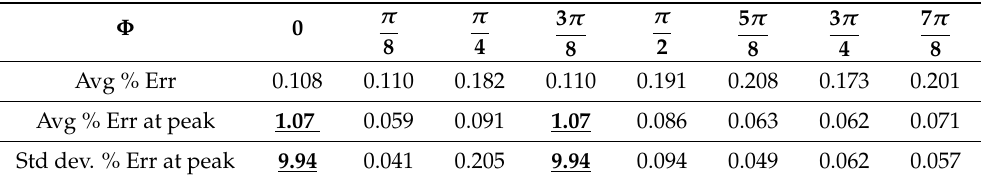
Figure 10. Legend for Figure 9. Table 7. Percent Error for CS reconstruction for each Φ for R = 42,000 km. The second row shows average % error over all time samples, the third row shows average % error at t 0 , and the last row shows the standard deviation of the % error at t 0